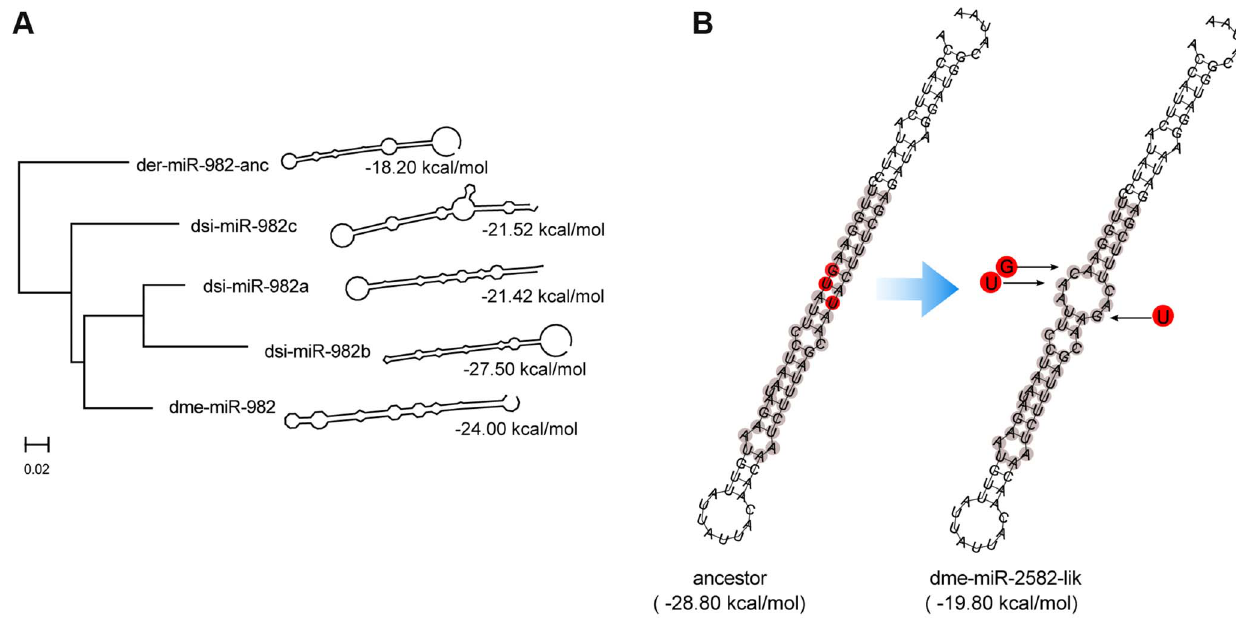
Figure 3. Evolution of the secondary structure of members of miR-982s as predicted by RNAfold [ 70 ] . ( A ) The thermo-stability of each hairpin is shown as kcal/mole at the tip of the branch. The phylogenetic tree is reconstructed based on the precursor sequences by the maximum likelihood method. ( B ) Disruption of dme-miR-2582-like hairpin structure by point mutations. Red nucleotide bases are the three lineage-specific mutations that disrupted the duplex. Gray nucleotide bases are the consensus miR:miR* duplex of miR-2582 inferred from dsi-miR-2582a/b.